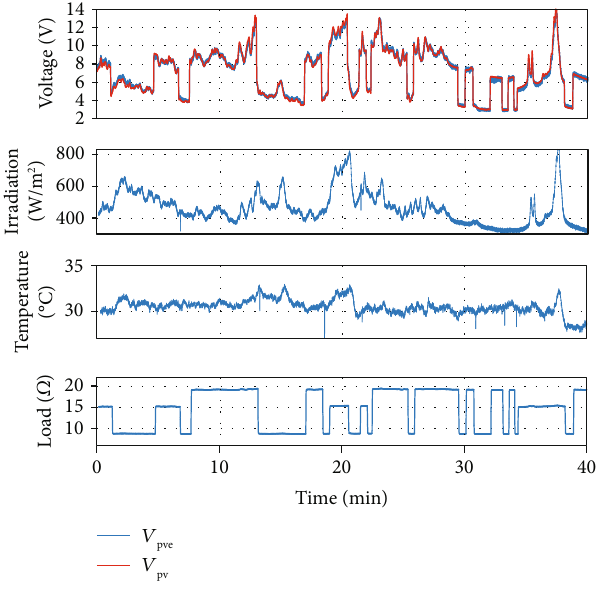
Figure 16: Proposed emulator test under simultaneous variation of load and environmental